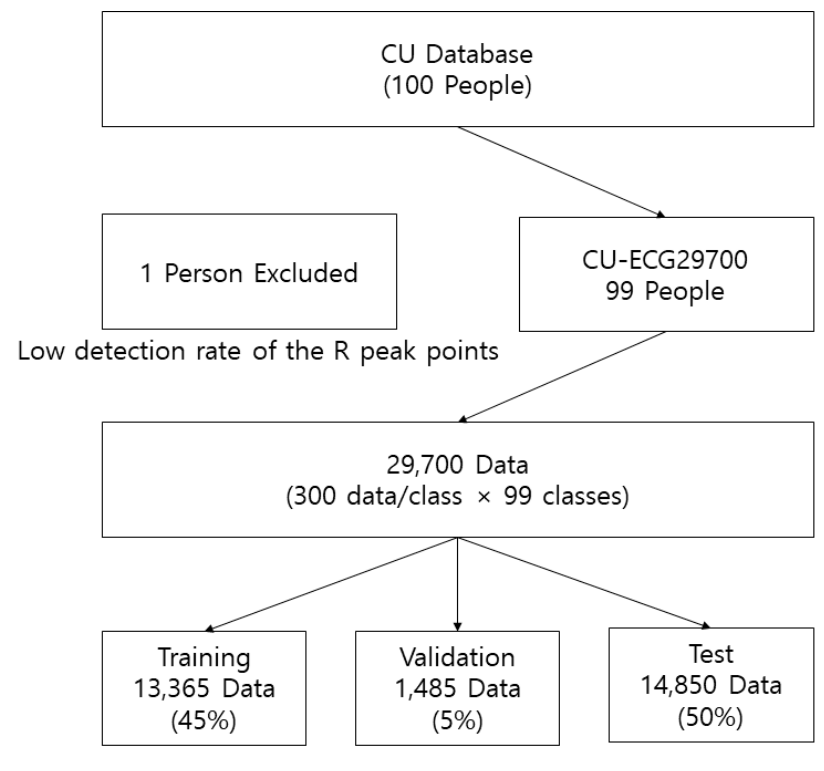
Figure 13. Structure of CU-ECG. Table 4. Accuracies achieved by PCA-L2 using time-frequency representations on CU-ECG.